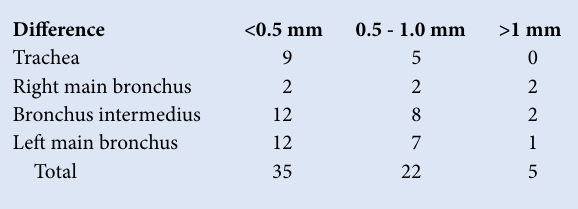
Table I. The difference in millimetres between axial measurements and measurements after MPR in the longitudinal axis (total number of stenoses = 62) Difference <0.5 mm 0.5 - 1.0 mm >1 mm Trachea Right main 